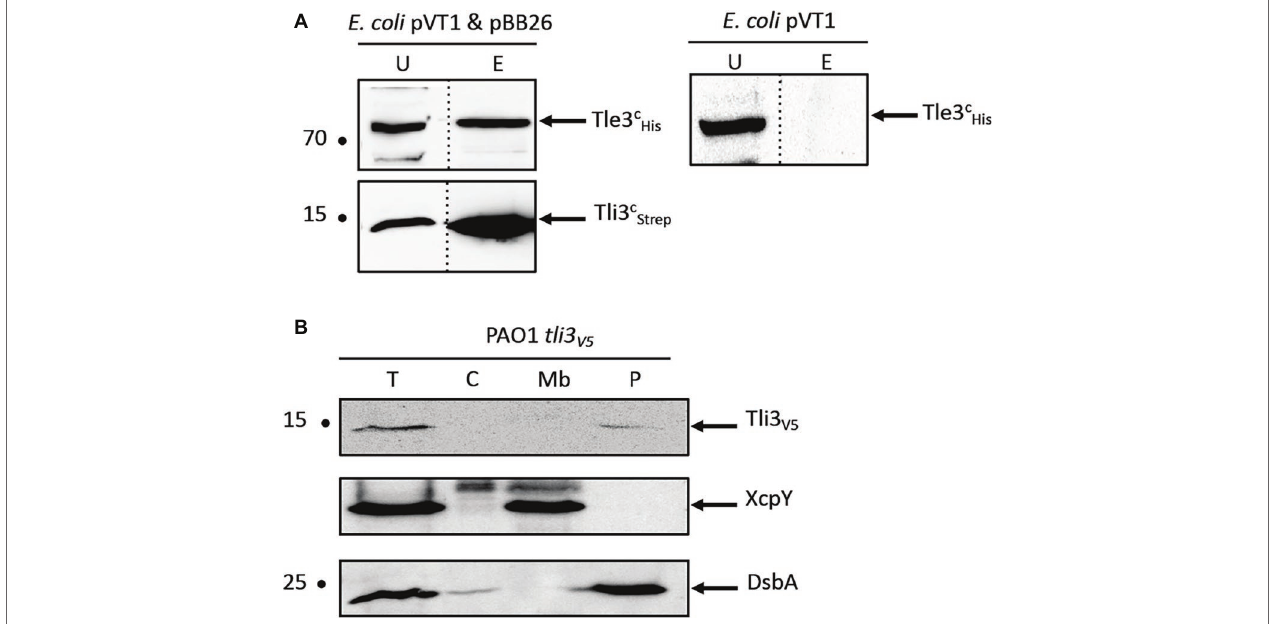
FIGURE 2 | (A) Tli3 (PA0261) interacts with Tle3. Copurification assay on StrepTactin column of Tli3c Strep with Tle3c10 His produced in E. coli BL21(DE3)pLysS produced from pBB26 and pVT1 respectively. The unbound (U) and eluted (E) fractions were collected and subjected to SDS-PAGE (10.5%) and Western blot analyses using anti-His antibody (Upper) and anti-streptavidin antibody (Lower). The position of the proteins and the molecular mass markers (in kDa) are indicated. (B) Tli3 (PA0261) is a periplasmic protein in P. aeruginosa . Cells of P. aeruginosa PAO1 tli3 V5 were subjected to fractionation and immunoblotting using antibodies directed against the V5 tag, XcpY and DsbA. XcpY and DsbA were used as membrane and periplasmic controls, respectively. T, whole cell; C, cytoplasm; Mb, total membrane; P, periplasm. The position of the proteins and the molecular mass markers (in kDa) are